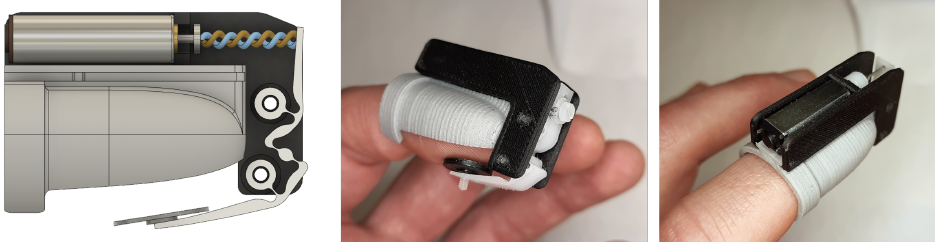
Figure 9. CAD of the internal components of the final design, and pictures of the implemented prototype, evidencing the slim design of the main body (black plastic) and the interchangeable soft thimble (light gray